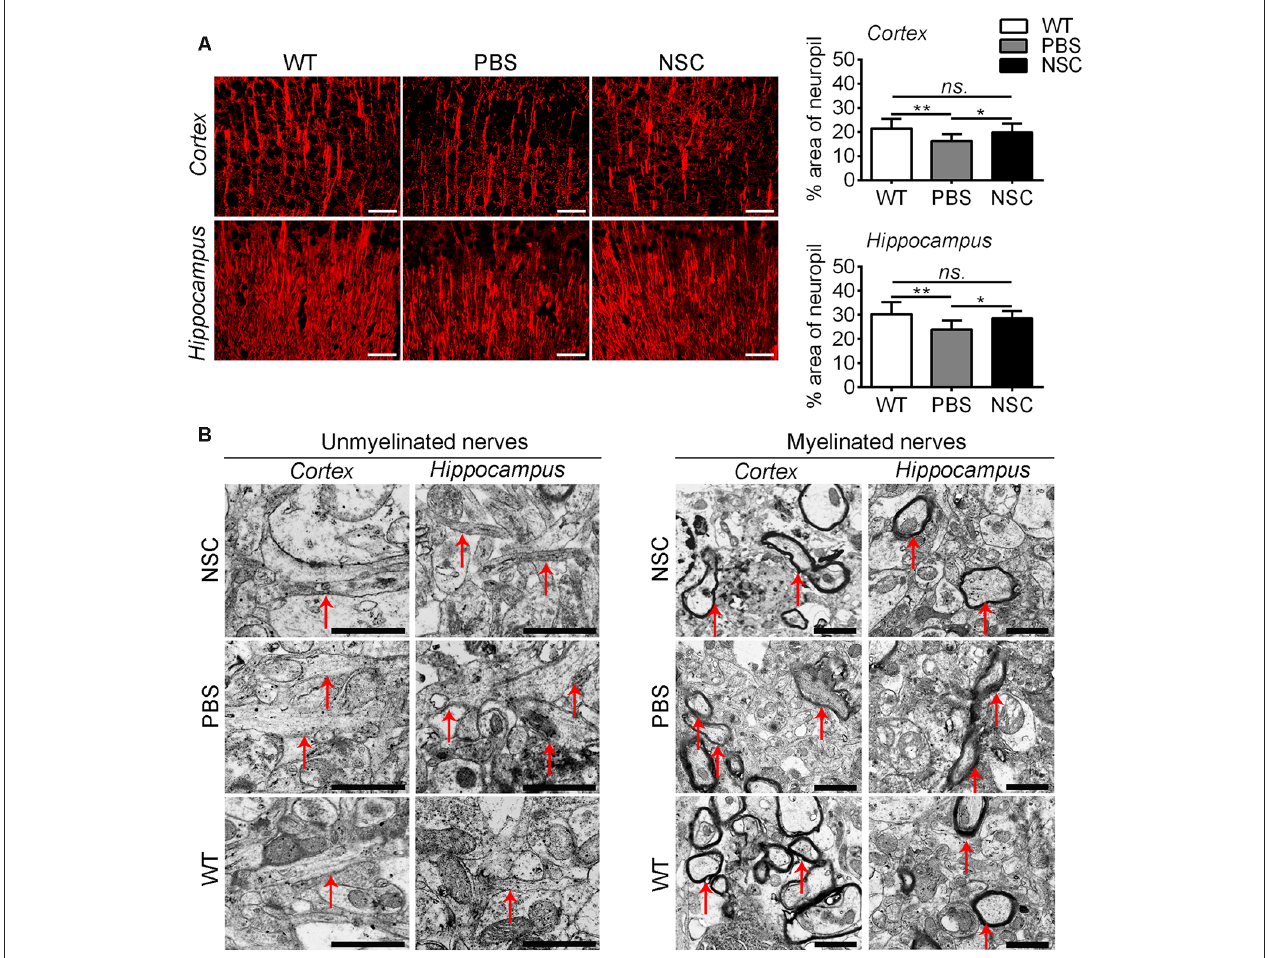
FIGURE 6 | hNSCs improved nerve fibers in APP/PS1 mice brains. (A) Microtubule associated protein 2 (MAP2)-staining sections in the brains of PBS, NSC group and WT mice, and quantification of MAP2-staining in the frontal cortex and hippocampus of three groups of mice. There was no significant difference in % area of neuropil between the NSC group and WT mice ( ns. = p > 0.05), ∗ p < 0.05; ∗∗ p < 0.01 vs. the PBS group. Scale bar: 20 µ m. (B) Ultrastructure analysis showed the enlargement and disorganization of unmyelinated nerves in the cortex and hippocampus of PBS group mice; the damage was alleviated in NSC group. Likewise, myelinated nerves maintained relatively intact in myelin sheath in NSC group and WT mice. Arrow indicates the nerve fibers. Scale bar: 1 µ